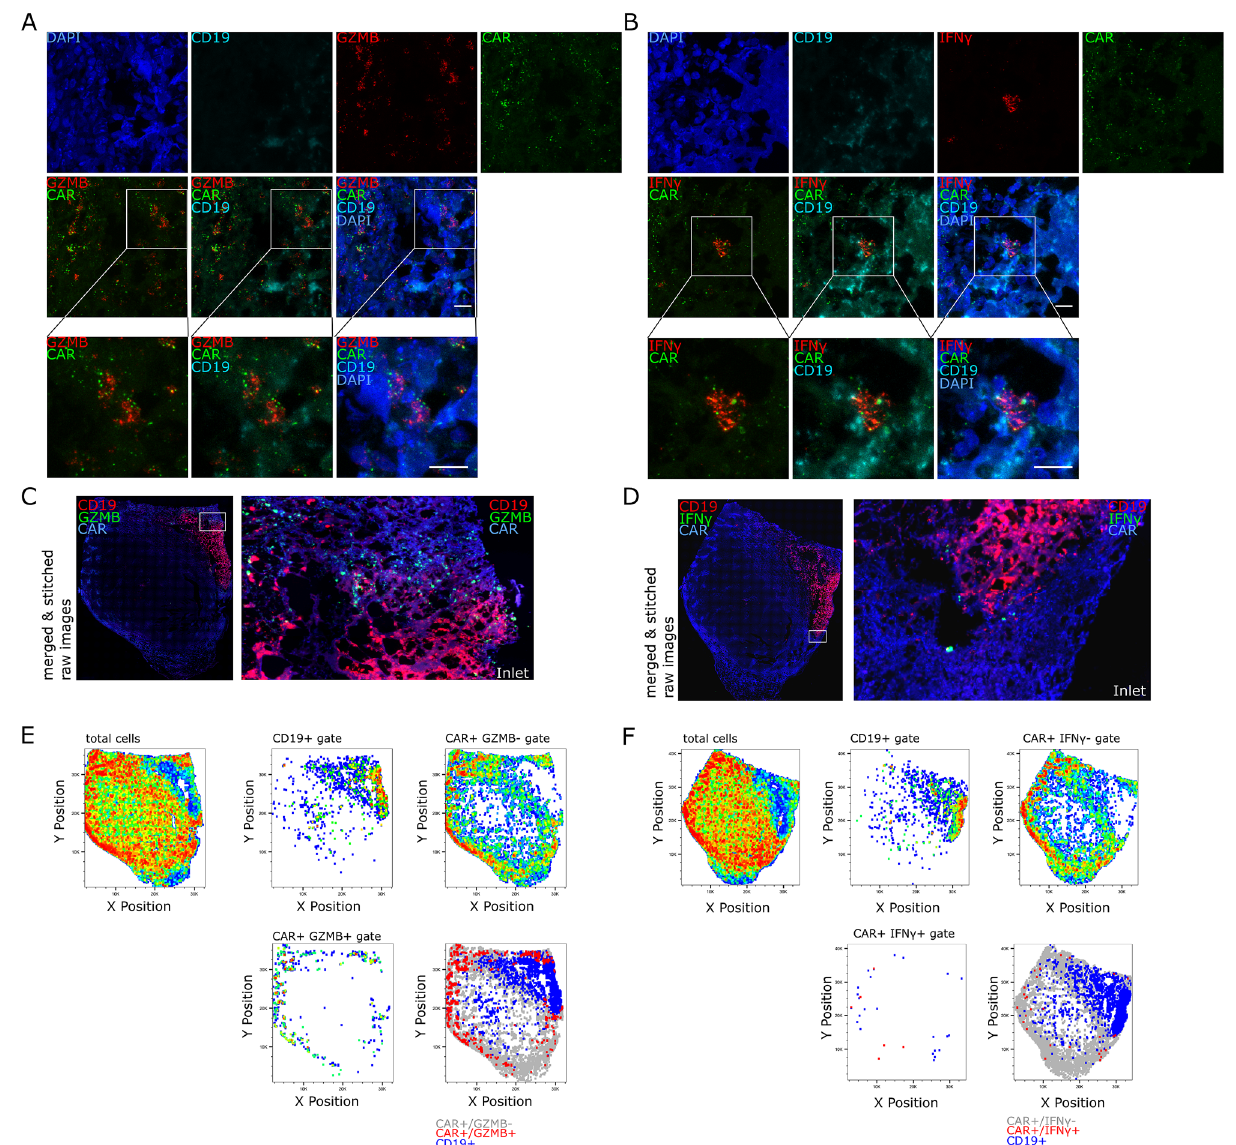
Figure 4. GZMB and IFNγ are highly expressed in a minority of CAR+ cells. CAR T cell functional phenotyping in a FFPE BE2 neuroblastoma xenograft was done by staining with DAPI, WGA, IHC for tumor marker CD19 and CAR RNA FISH in combination with either GZMB (n = 5) or IFNγ RNA FISH (n = 5). Confocal images show GZMB RNA ( A ) or IFNγ RNA ( B )-expressing CAR T cells in close proximity in a representative area close to the residual CD19+ tumor. The whole tissue overview images of CAR RNA, CD19 with either GZMB RNA ( C ) or IFNγ RNA ( D ) staining shows the global distribution of the different markers. Whole tissue RRS analysis of the two RNA FISH, the CD19 IHC, the WGA and DAPI channel of each single tile was performed and the various x–y plots depict the spatial distribution of CD19+ , CAR+ and GZMB + ( E ) cells or IFNγ + cells ( F ) within the tumor section. Scale bar = 10